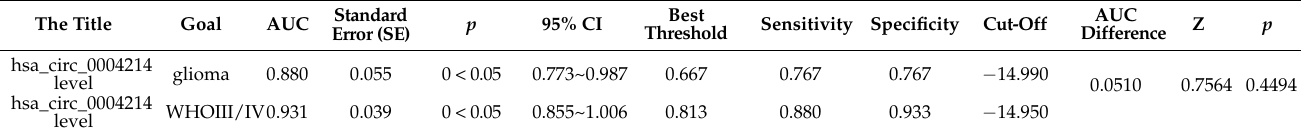
Table 4. ROC results AUC